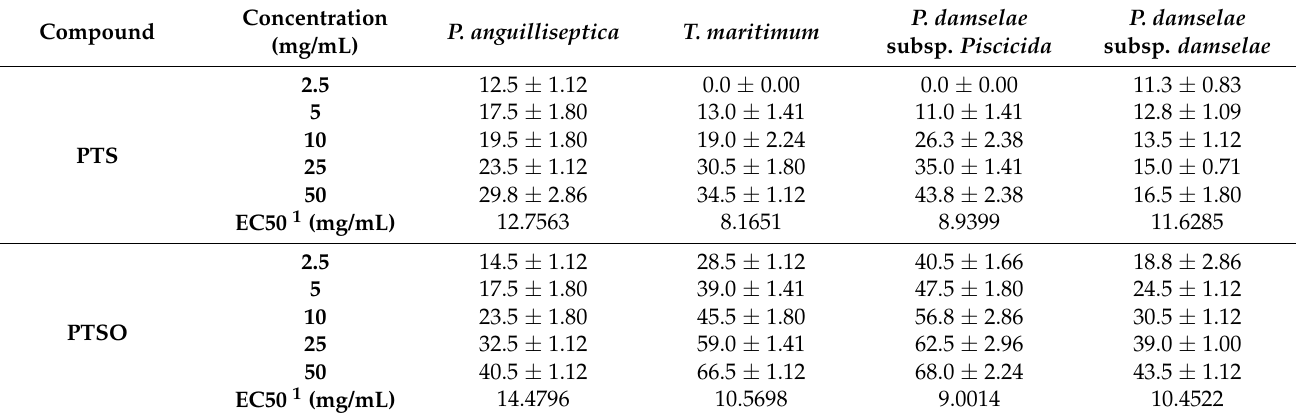
Table 1. Antibacterial activity of PTS and PTSO at different concentrations against pathogenic bacteria that infected S. aurata by the disk-diffusion method, expressed as the average diameter ± standard deviation of the inhibition zone (mm), along with EC50